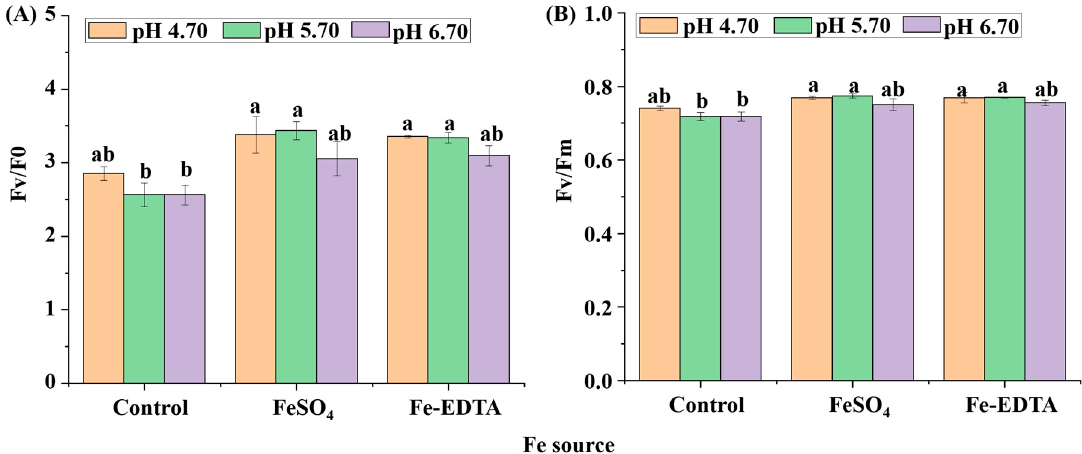
Figure 6. The chlorophyll fluorescence parameters Fv/F0 ( A ) and Fv/Fm ( B ) of H. macrophylla leaves after 60 days of culture. Lowercase letters indicate significant differences calculated by Duncan’s multiple range test at p ≤ 0.05. Vertical bars indicate the standard error ( n = 3).